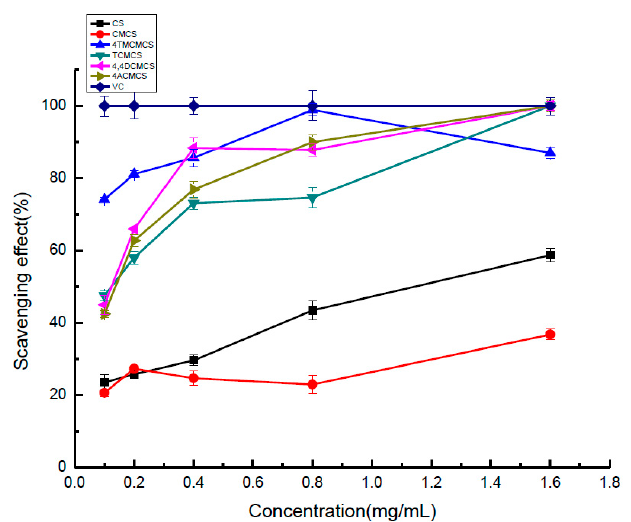
Figure 5. DPPH radicals’ scavenging ability of CS, N, O- CMCS, and Carboxymethyl chitosan containing thiourea salts.